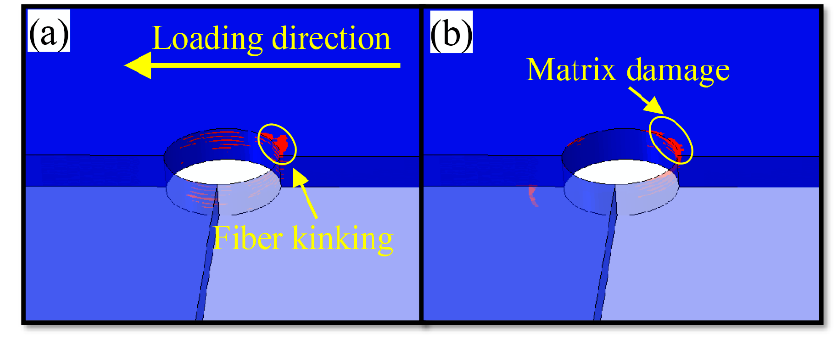
Figure 8. FEM results of hole circumference at A (( a ) fiber kinking, ( b ) matrix damage).